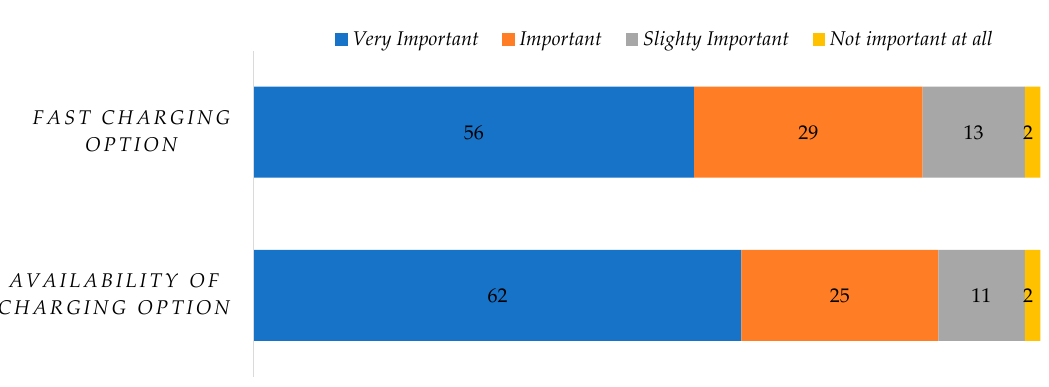
Figure 4. Influence of charging option on customer purchase of EVs Figure 4 . Influence of charging option on customer purchase of EVs [75].